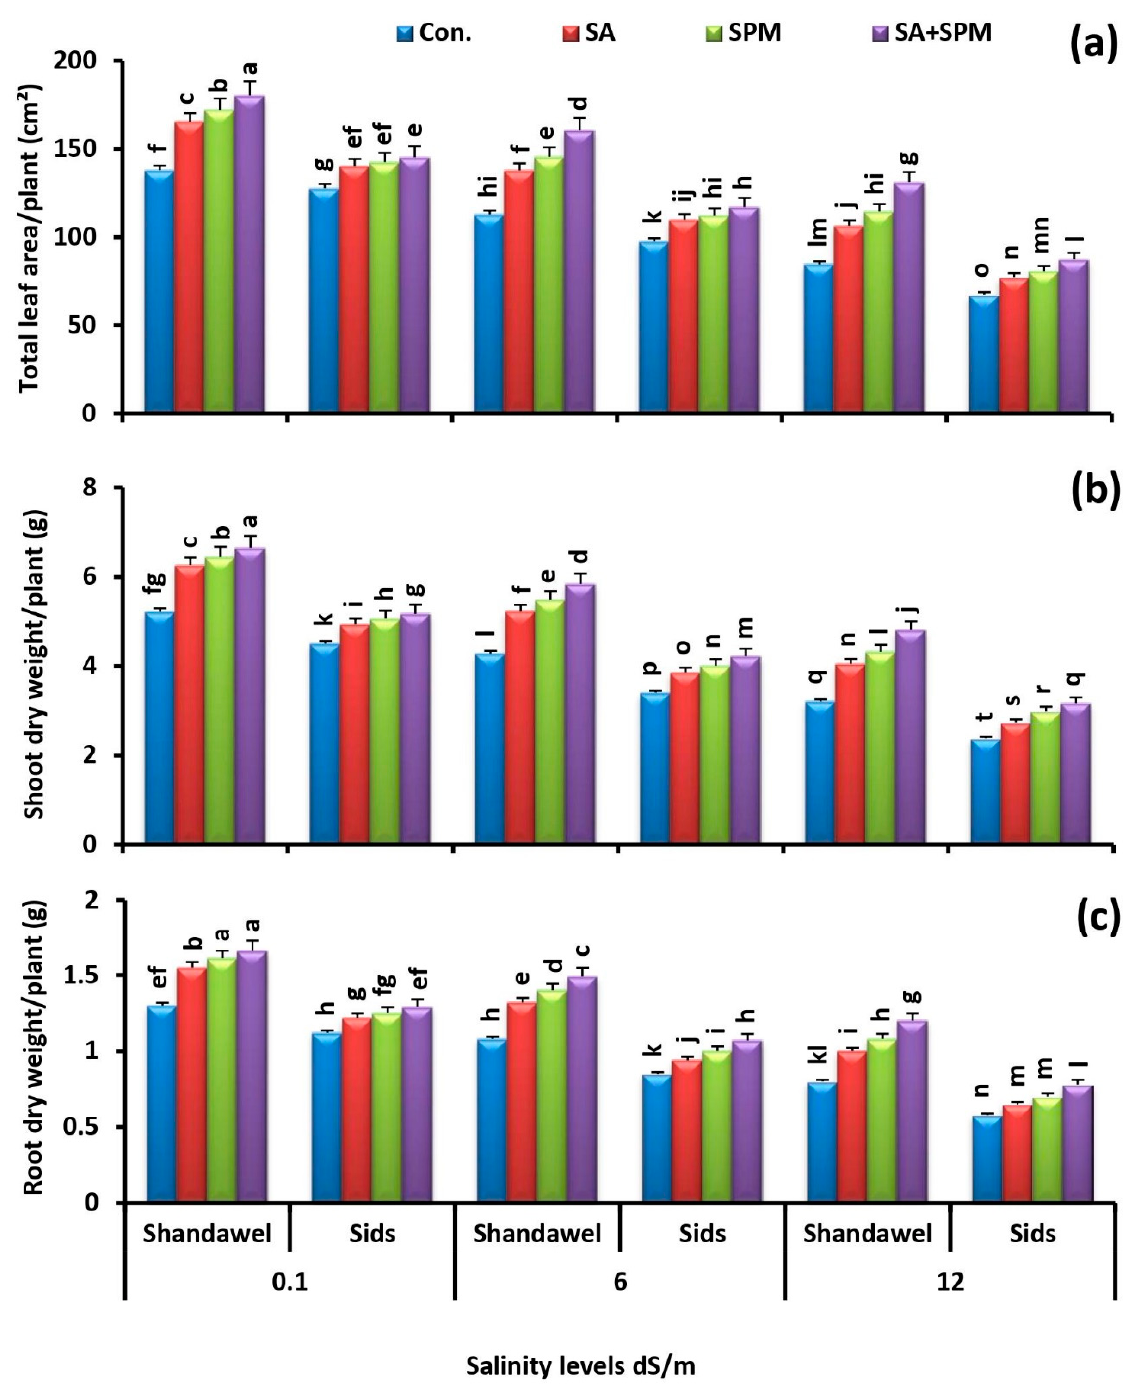
Figure 1. Influence of salicylic acid (SA; 100 mgL − 1 ) and/or spermine (SPM; 30 mgL − 1 ) on the ( a ) total leaf area, ( b ) shoot dry weight, and ( c ) root dry weight of two wheat cultivars (Shandawel 1 and Sids 14) grown under 0.1, 6, and 12 dS m − 1 salinity levels. Data are mean of four replicates (n = 4). Different letters indicate significant differences at ( p < 0.05) level, according to Duncan’s test.